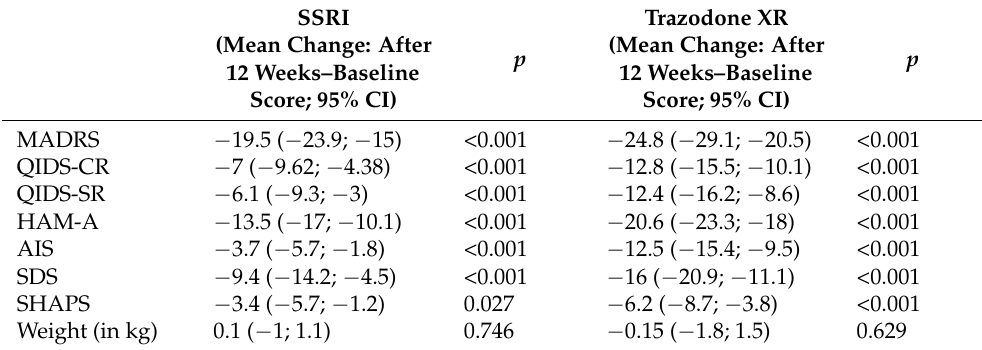
Table 5. Mean changes in outcomes scores and weight after 12 weeks of treatment (compared to baseline), as measured by repeated measures ANOVA. MADRS—Montgomery–Åsberg Depression Rating Scale; HAM-A—Hamilton Anxiety Rating Scale; QIDS-CR—Quick Inventory of Depressive Symptomatology, clinician rating; QIDS-SR—Quick Inventory of Depressive Symptomatology, self rating; SHAPS—Snaith–Hamilton Pleasure Scale; AIS—Athens Insomnia Scale; and CGI—Clinical Global Impression Scale.